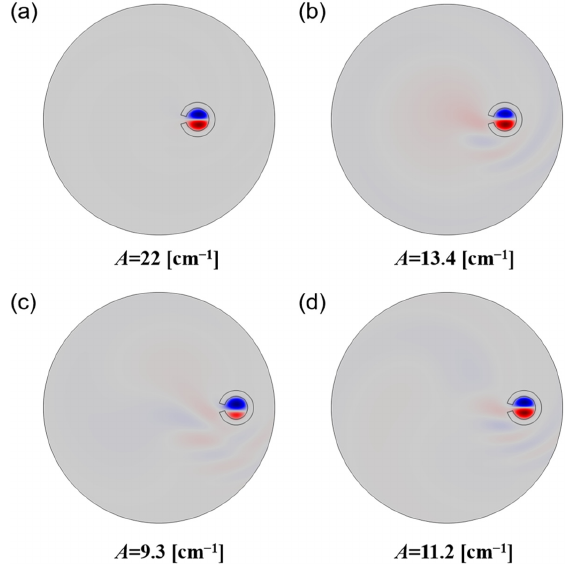
Figure 3. Transverse component of the electric field for chosen 𝐻𝐸 (cid:2869)(cid:2869)(cid:2879) core modes with R 2 = 1.5R 1 and ρ = 10 μ m ( a ), ρ = 15 μ m ( b ) and ρ = 20 μ m ( c , d ).